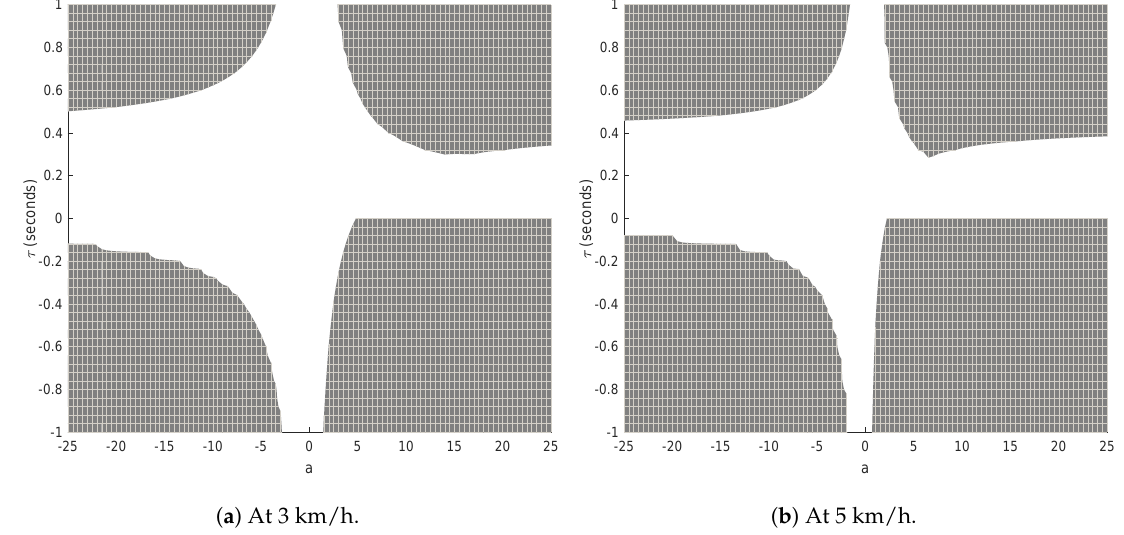
Figure 5. Regions of stability for different values of roll angle gain a and lead time τ for closed-loop system of